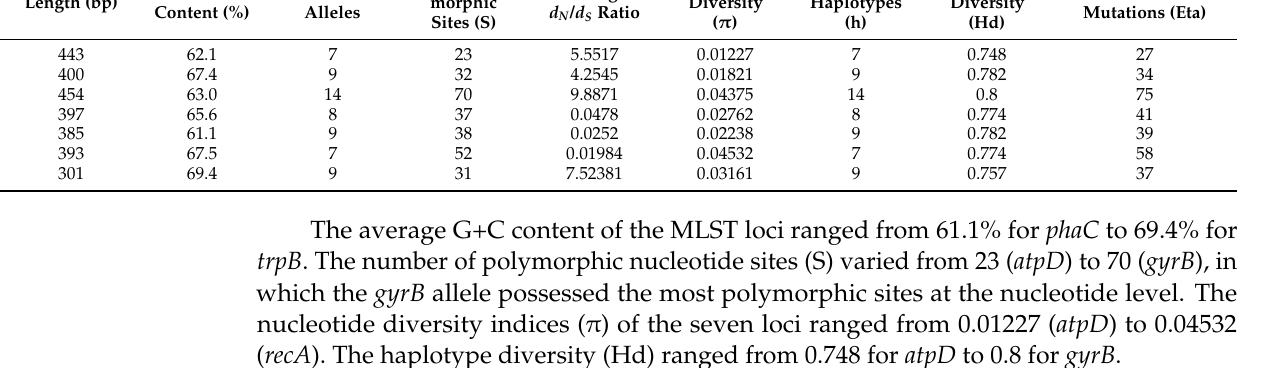
Table 3 summarizes data on the genetic diversity of the seven loci, including G+C content, number of alleles, number of polymorphic sites, nucleotide diversity ( π ), total number of mutations (Eta), number of haplotypes (h), haplotype diversity (Hd), and the ratio of nonsynonymous ( d N ) to synonymous ( d S ) substitutions. The number of alleles observed for each DNA fragment ranged from 7 ( atpD , recA ) to 14 ( phaC ), and the most frequently detected alleles at each locus were atpD 64 ( n = 17), gltB 80 ( n = 17), gyrB 76 ( n = 17), recA 89 ( n = 17), lepA 105 ( n = 17), phaC 97 ( n = 17), and trpB 70 ( n = 17), respectively. The number of different alleles present per locus in B. cenocepacia was highly diverse, including 3 ( atpD , recA , lepA ), 4 ( gltB , phaC ), 9 ( gyrB ), and 5 ( trpB ). On the contrary, only one allele was present per locus in B. contaminans . The frequency of each allele within each bacterial species is shown in Figure 2. Table 3. Nucleotide and allelic diversity of the seven loci in the 41 Burkholderia cepacia complex (BCC) isolates. Locus